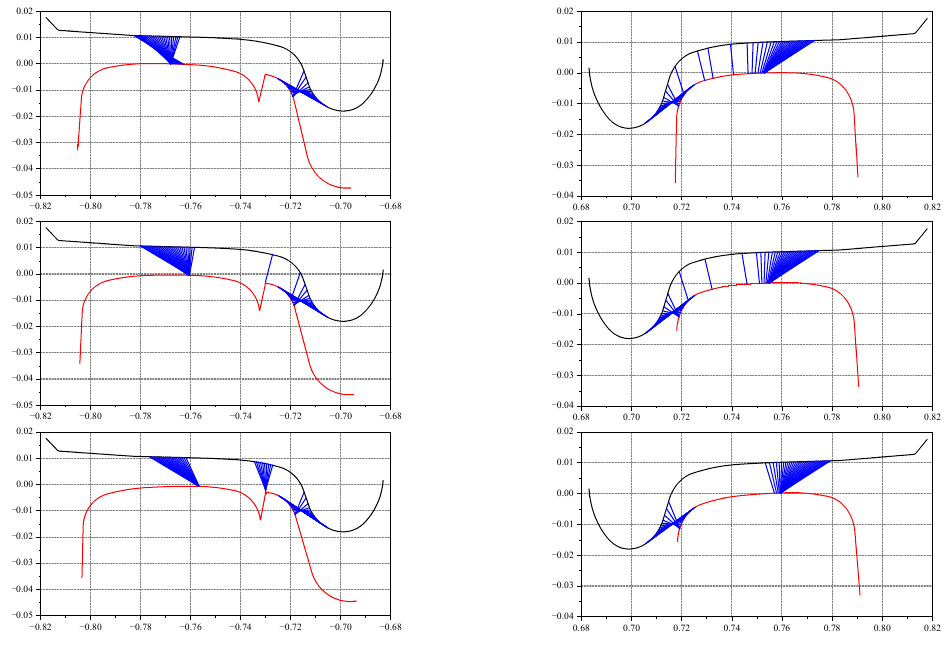
Figure 8. Wheel–rail contact position change of a typical cross-section.